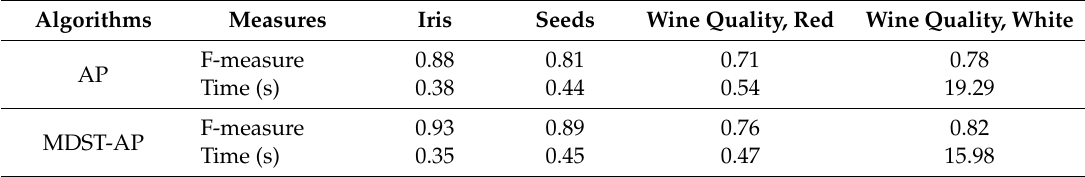
Table 2. Clustering results and computational time for di ff erent datasets. AP: a ffi nity propagation.